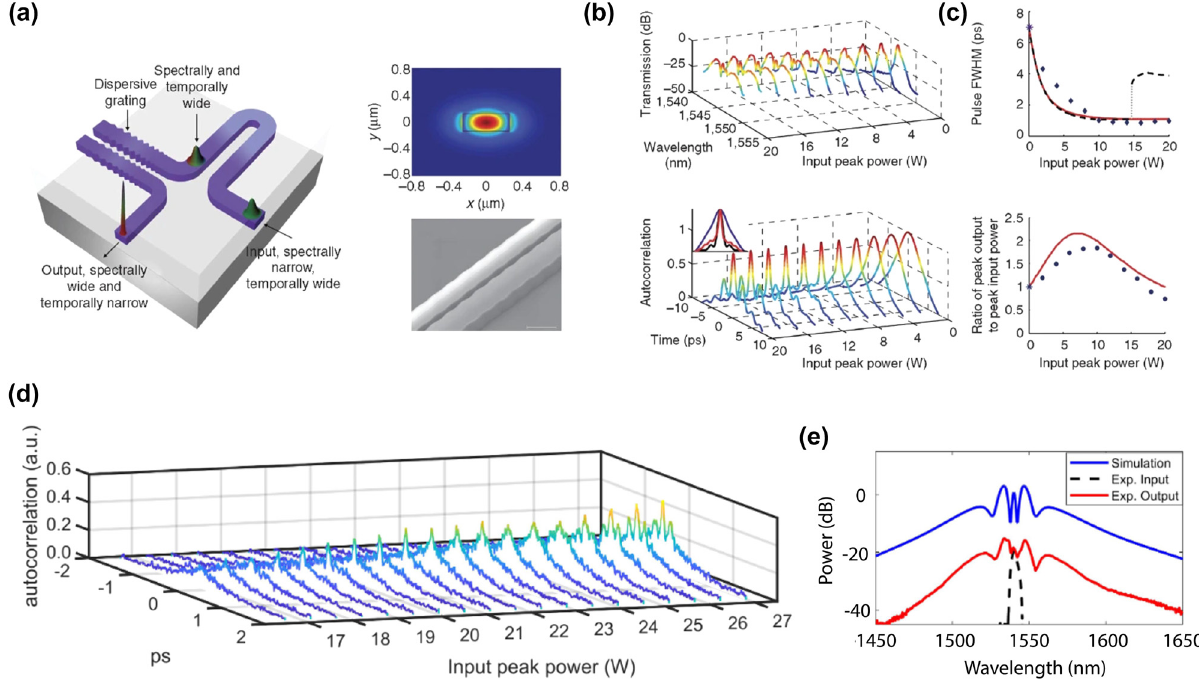
Figure 18: On-chip pulse compression. (a) Schematic of a two-stage pulse compression, calculated quasi-TE mode profile for silicon nanowire waveguide used for SPM (right, top) and SEM of dispersive grating (right, bottom). (b) Spectral output (top) and autocorrelation (bottom) as a function of input peak power. (c) Measured and calculated (red line) FWHM of the output pulse (top) and ratio of output peak power to input peak power, normalized to coupling and propagation losses as a function of input peak power. (d) Sequence of autocorrelation traces at the output of a 40 cm SiN waveguide while varying the input pulse peak power. (e) Experimental input and output spectra. Panels (a)–(c) adapted from [172]. Panels (d) and (e) adapted from